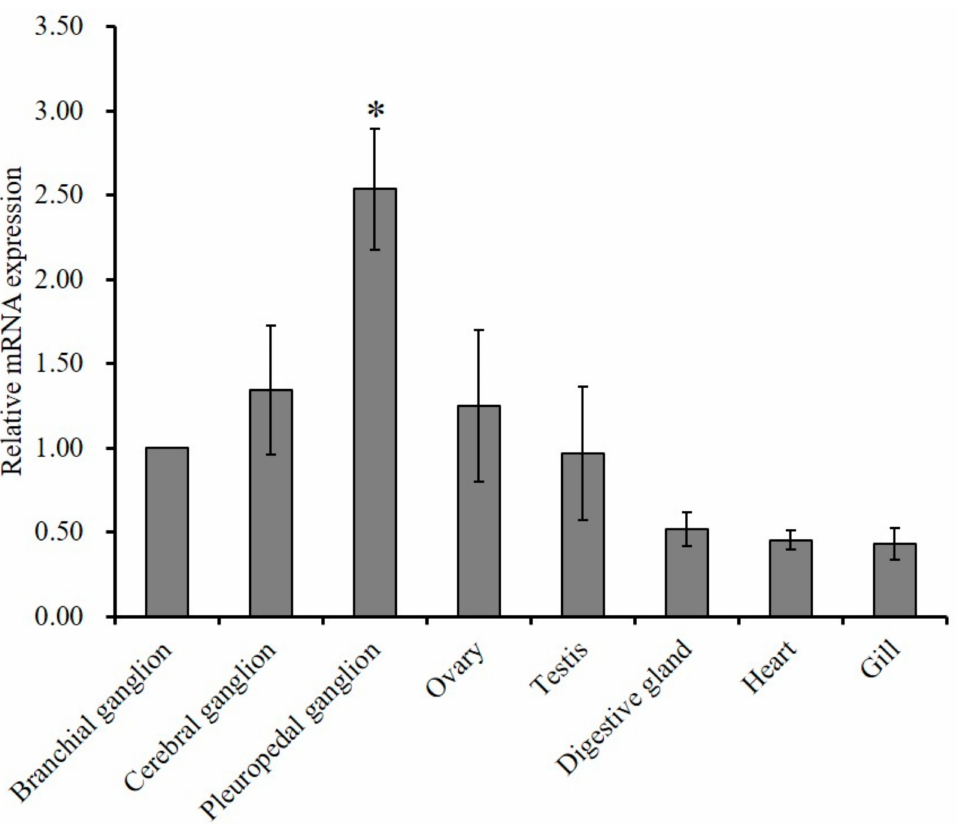
Figure 4. Quantitative PCR analysis of GnRH-R mRNA expression pattern (means ± SD, N = 3) in various tissues of abalone. Data were compared with the relative value of the branchial ganglion (1). Asterisks indicate significant di ff erences ( p ≤ 0.05).